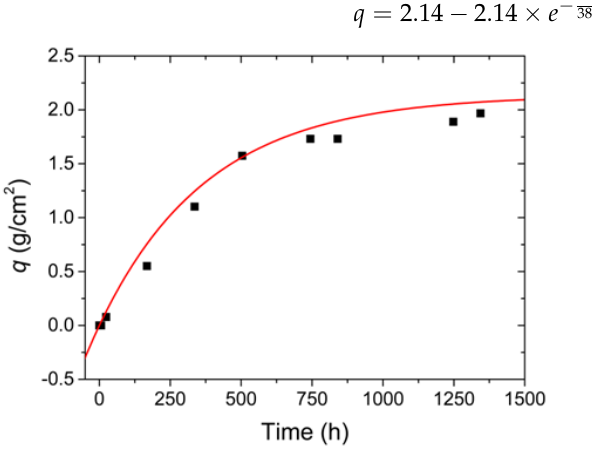
Figure 8. Variation of the calculated lost mass with the corrosion action time using Equation (7) (red line) and the obtained values from Table 3 (black squares).